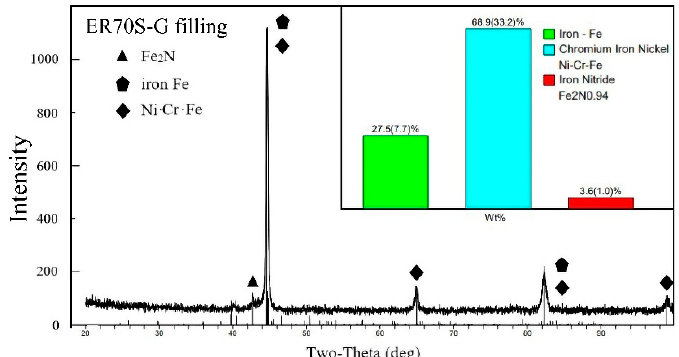
Figure 5. XRD phase detection spectrum (ER70S-G filling).